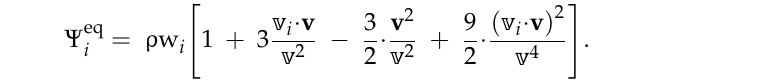
Figure 1. Two typical lattices often used in LB simulations: ( a ) D2Q9; and ( b ) D3Q19.